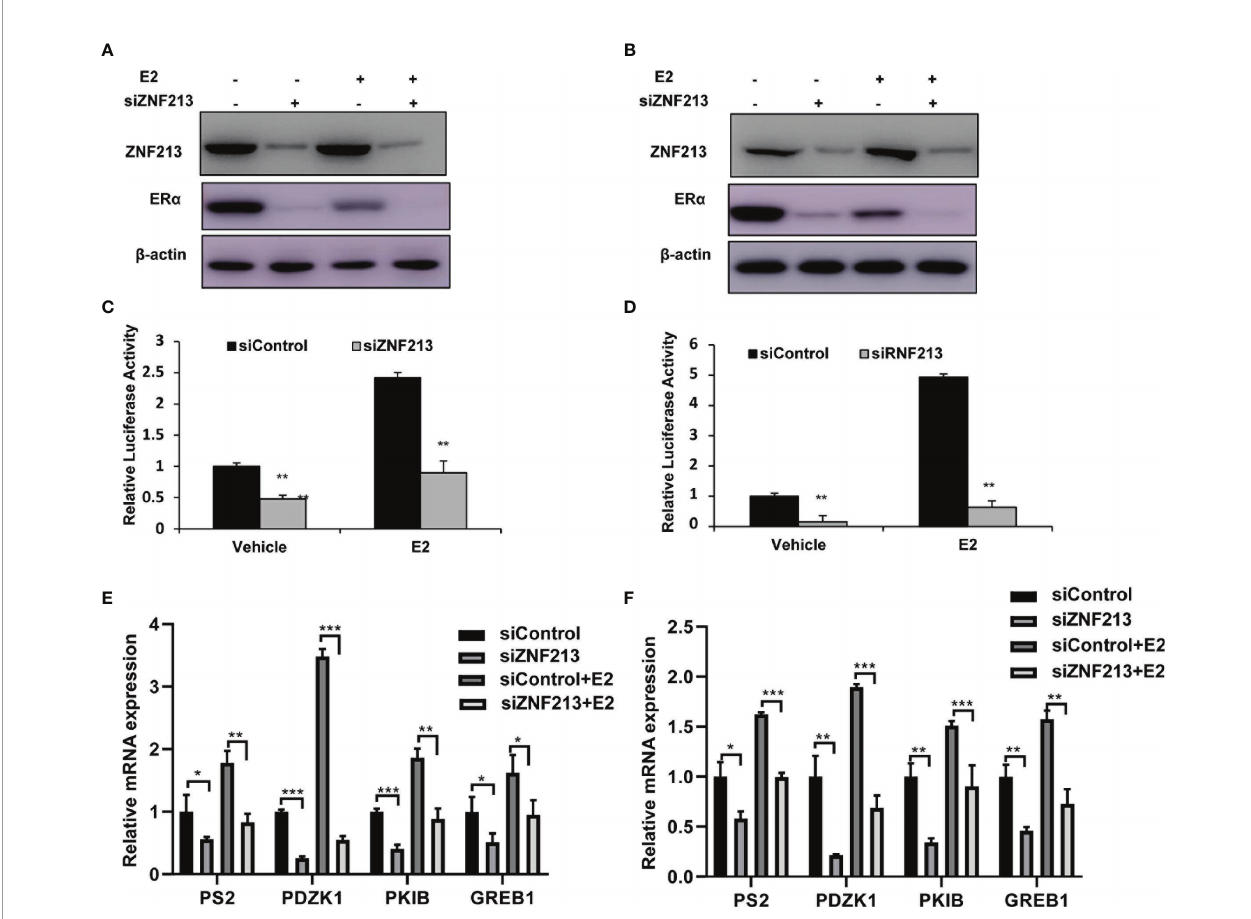
FIGURE 3 | ZNF213 depletion inhibits ER alpha protein and ER alpha target genes in breast cancer cells (A, B) ZNF213 depletion effect on ER alpha protein level in MCF-7and T47D cells. Cells were transfected with siZNF213 or siControl. After 48 h, cells were treated with either ethanol or 10 nM estradiol for 6 h. ZNF213 and ER alpha protein levels were determined by Western blot analysis. Actin was used as internal control. (C, D) ZNF213 depletion affects ERE-luciferase activity in MCF-7and T47D cells. Cells were transfected with siZNF213 or siControl together with ERE luciferase reporter plasmid. Cells were treated with 10 nM estradiol or vehicle. Luciferase activity was measured 48 h after transfection. Shown are the results from three experiments. **P < 0.01 for luciferase activity comparison. (E, F) ZNF213 depletion decreases ER alpha target genes in MCF-7and T47D cells. Cells were transfected with siZNF213 or siControl. After 48 h, cells were treated with either ethanol or 10 nM estradiol for 6 h. Total RNA was prepared and the expression of the endogenous ER alpha target genes, PS2, GREB1, PKIB, and PDZK1 were determined by qPCR. Shown are the results from three experiments. *P < 0.05; **P < 0.01; ***P < 0.001 for target gene expression